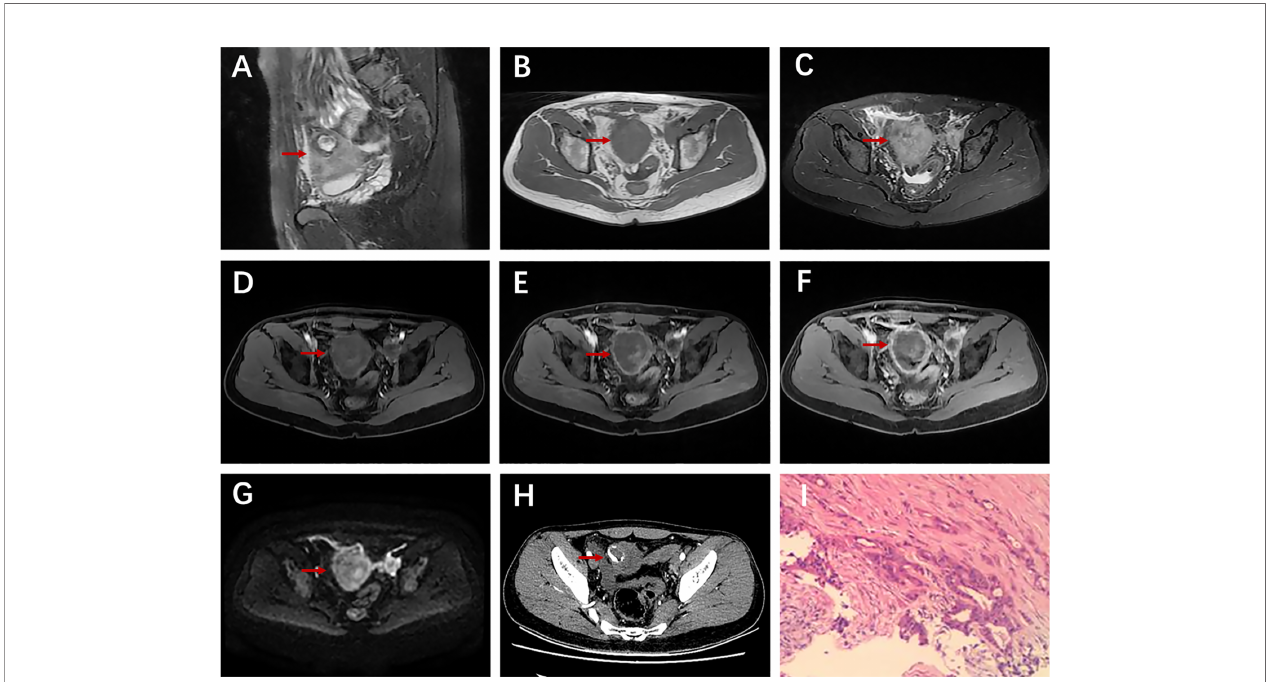
FIGURE 1 | A 28-year-old man with urachal carcinoma presented with hematuria, pollakiuria, and dysuria. Sagittal T2WI (A) showed a mass containing cystic elements at the dome of the bladder; iso-intensity signal on T1WI (B) and high-intensity signal on T2WI (C) ; axial dynamic contrast-enhanced LAVA-Flex images showed progressive ring enhancement (D – F) ; restricted diffusion on DWI especially at the edge of the mass (G) ; ring-shaped calci fi cation on axial unenhanced CT scan (H) ; histopathological fi ndings con fi rmed a moderately differentiated adenocarcinoma of the urachus (I) .